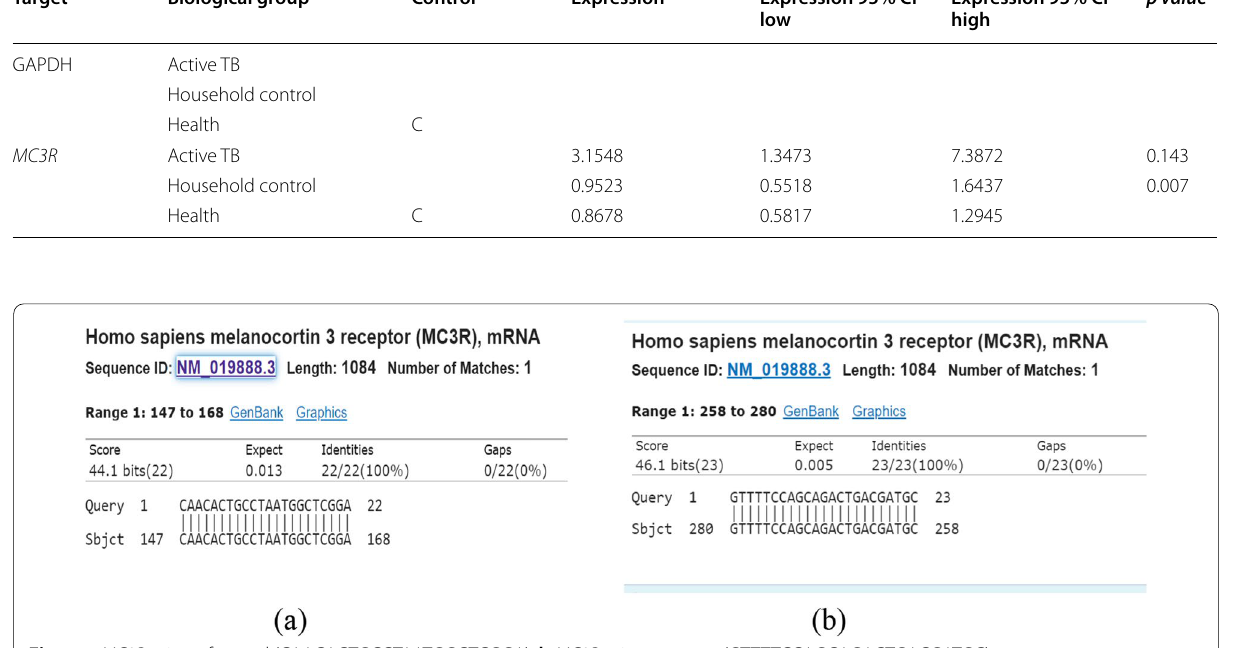
Fig. 1 a MC3R primer forward (CAA CAC TGC CTA ATG GCT CGGA); b MC3R primer reverse (GTT TTC CAG CAG ACT GAC